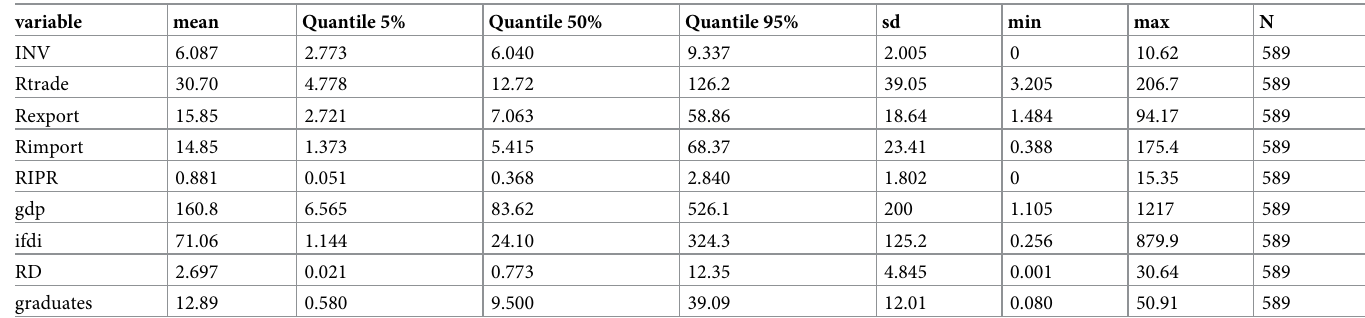
Table 2. Descriptive statistics of key variables.